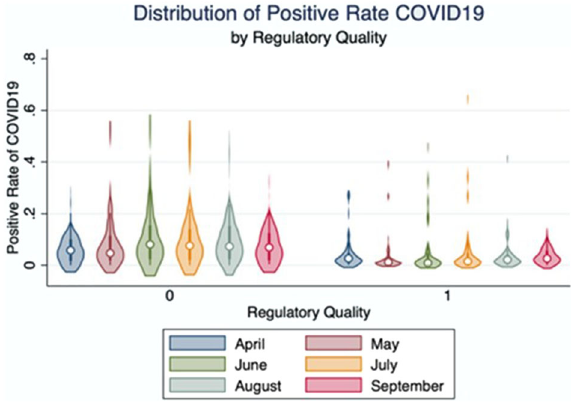
Fig. 9 Distribution of the COVID-19 positive rate by regulatory quality.